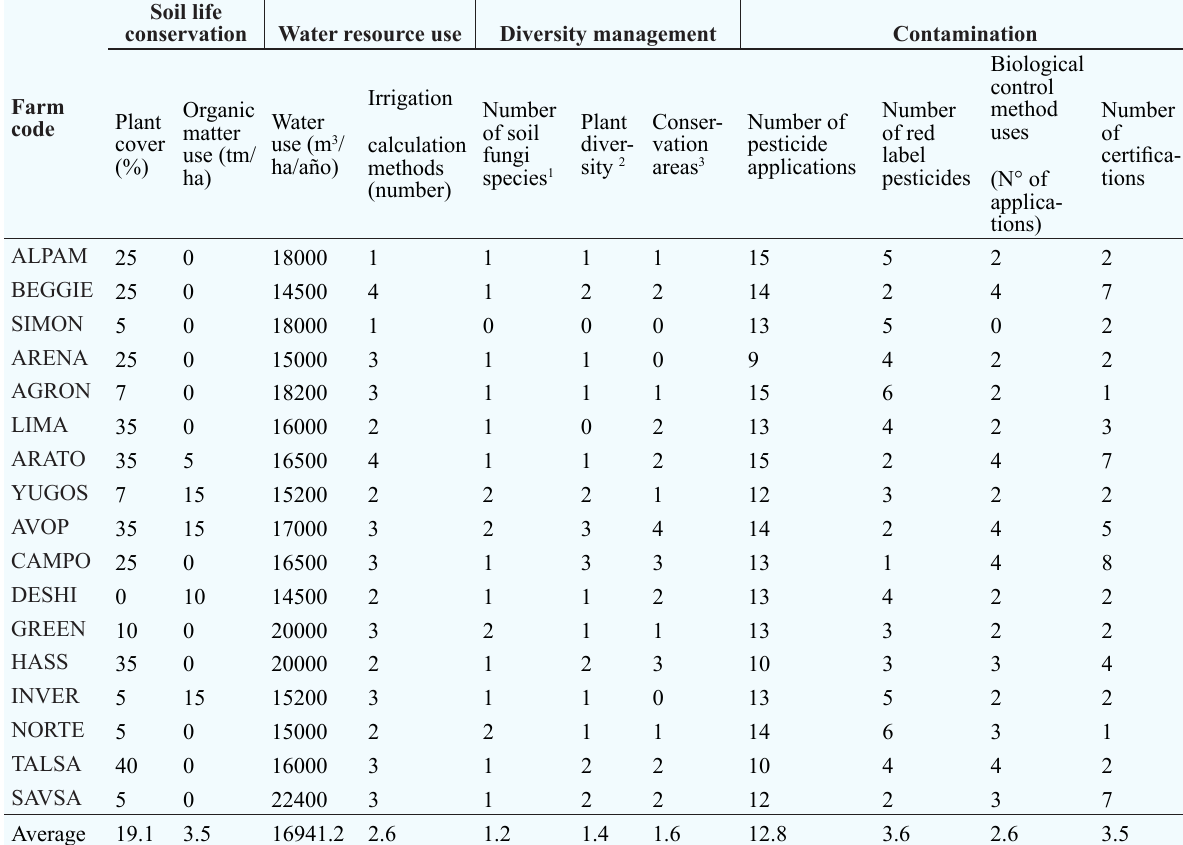
Table 3. Environmental indicators of avocado farms of the Chavimochic irrigation project in December 2017.